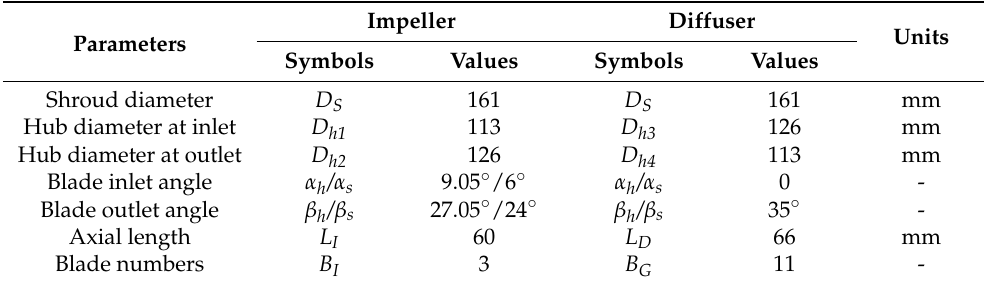
Figure 1. A photograph of the multiphase pump. Table 1. Design parameters of the impeller and diffuser.